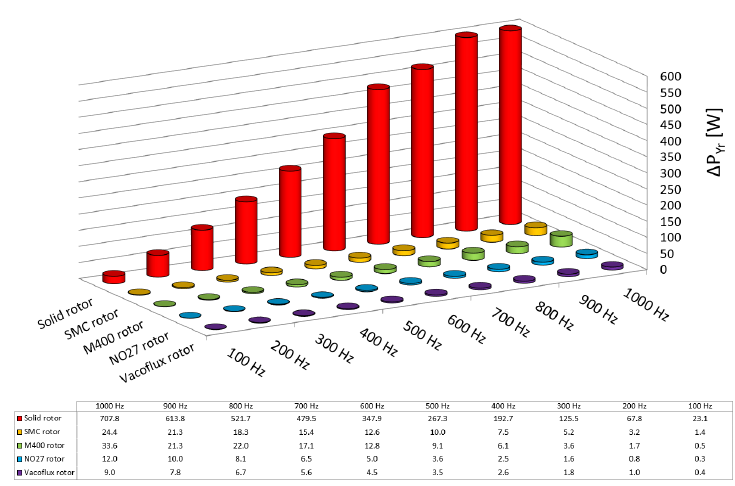
Figure 4. The value of the calculated losses in the rotor yoke Δ P Yr for individual solutions as a function of the supply frequency for the current density in the winding J = 15 A/mm 2 .